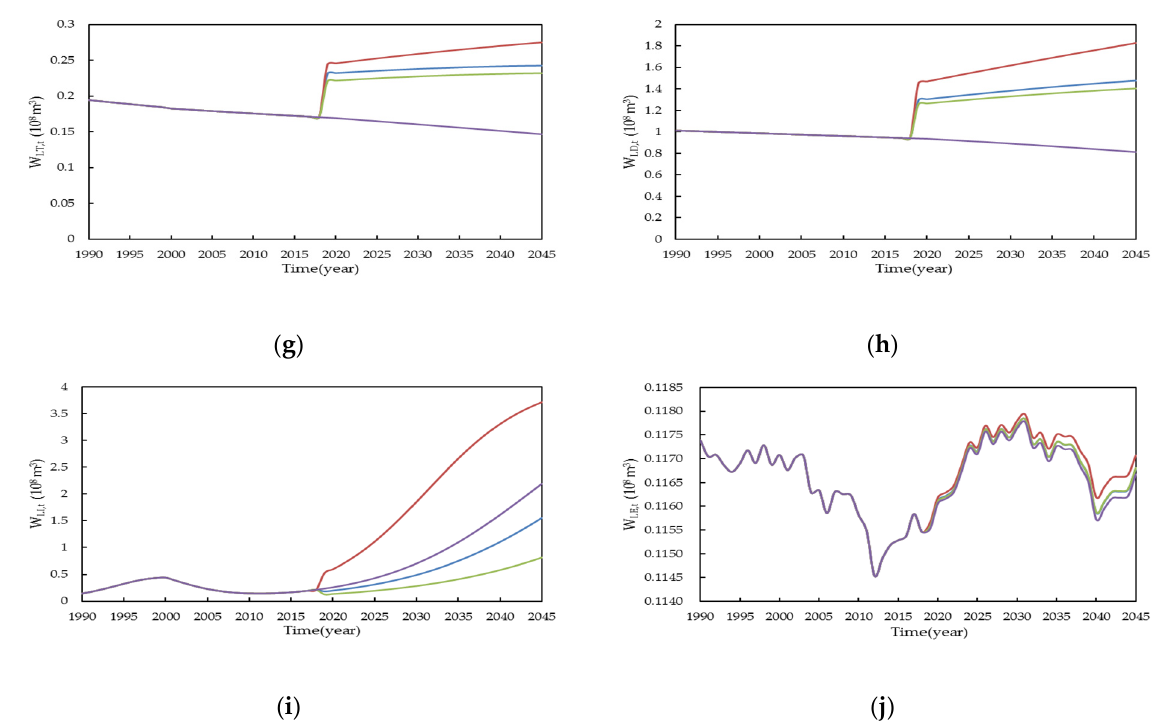
Figure 5. The future evolution of the main variables in the lower section. ( a ) Population in the lower section, ( b ) urban population in the lower section, ( c ) cultivable land area in the lower section, ( d ) industrial added value in the lower section, ( e ) water consumption in the lower section, ( f ) agricultural water consumption in the lower section, ( g ) tertiary industry water consumption in the lower section, ( h ) domestic water consumption in the lower section, ( i ) industrial water consumption in the lower section, ( j ) environmental water consumption in the lower section.